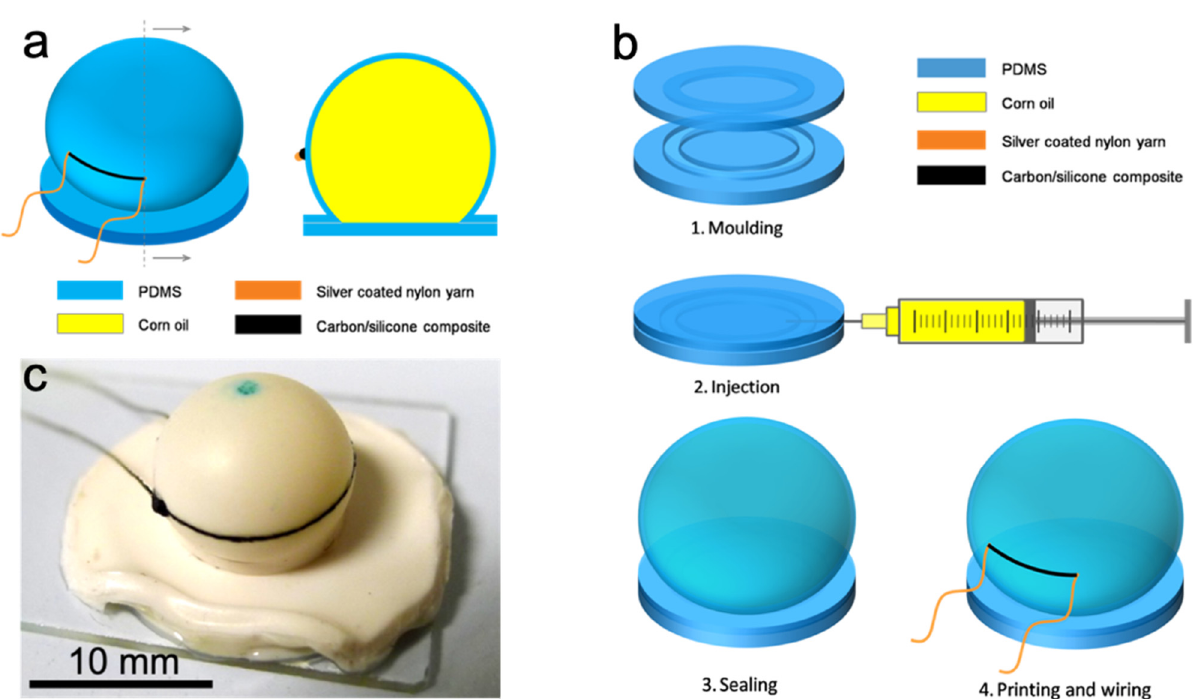
Figure 3. ( a ) Schematic of a cell-type pressure sensor. Left is an oblique view and right is a front view of the cross section. ( b ) Fabrication process of the cell-type pressure sensors. (1) Molding of the PDMS layers; (2) Injection of the corn oil; (3) Sealing of the cell; (4) Printing of the strain gauge and connection of the wires. ( c ) Picture of an as-made soft cell-type pressure sensor. The diameter of the cell is 11 mm. The green marking on top is for contraposition in fabrication.